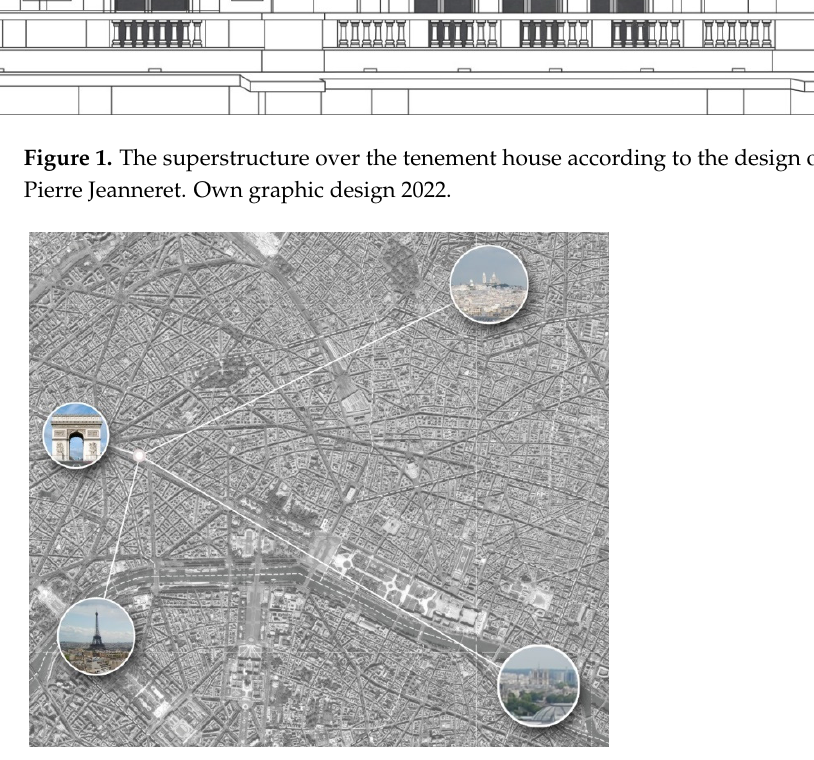
Figure 1. The superstructure over the tenement house according to the design of Le Corbusier and Pierre Jeanneret. Own graphic design 2022.